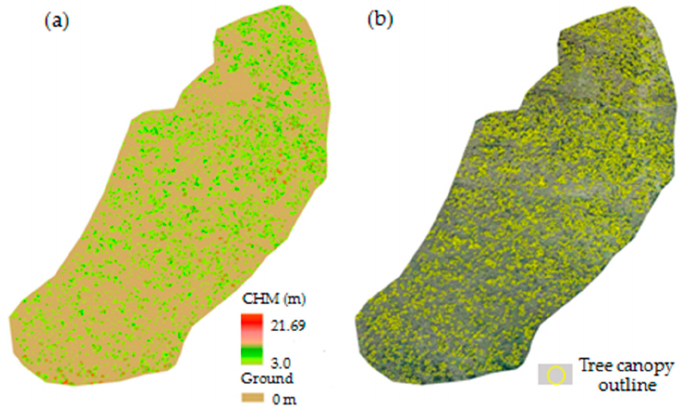
Figure 9. The CHM of Minjiang fir trees and the spatial outlines of individual tree canopies.